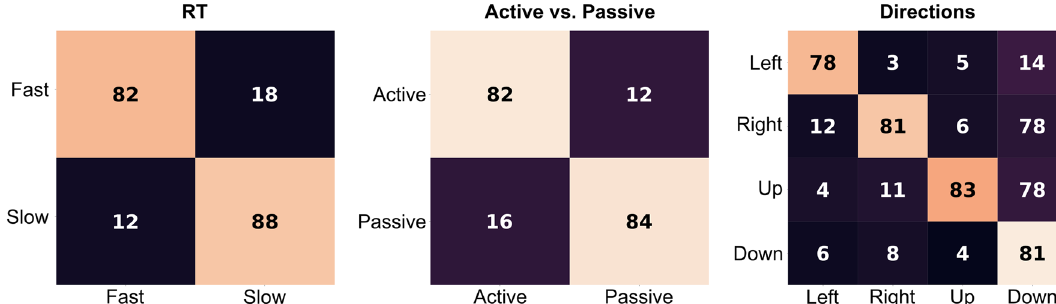
Figure 4. Averaged confusion matrices for the three classification tasks when evaluated using leave-one-out. Numbers are in